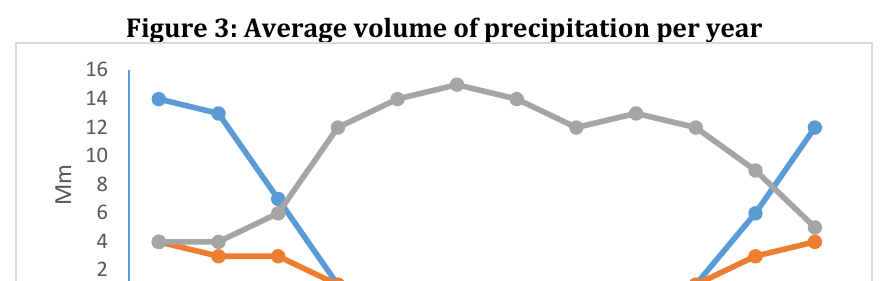
Source : based on (Climate in Kyiv) Figure 3: Average volume of precipitation per year